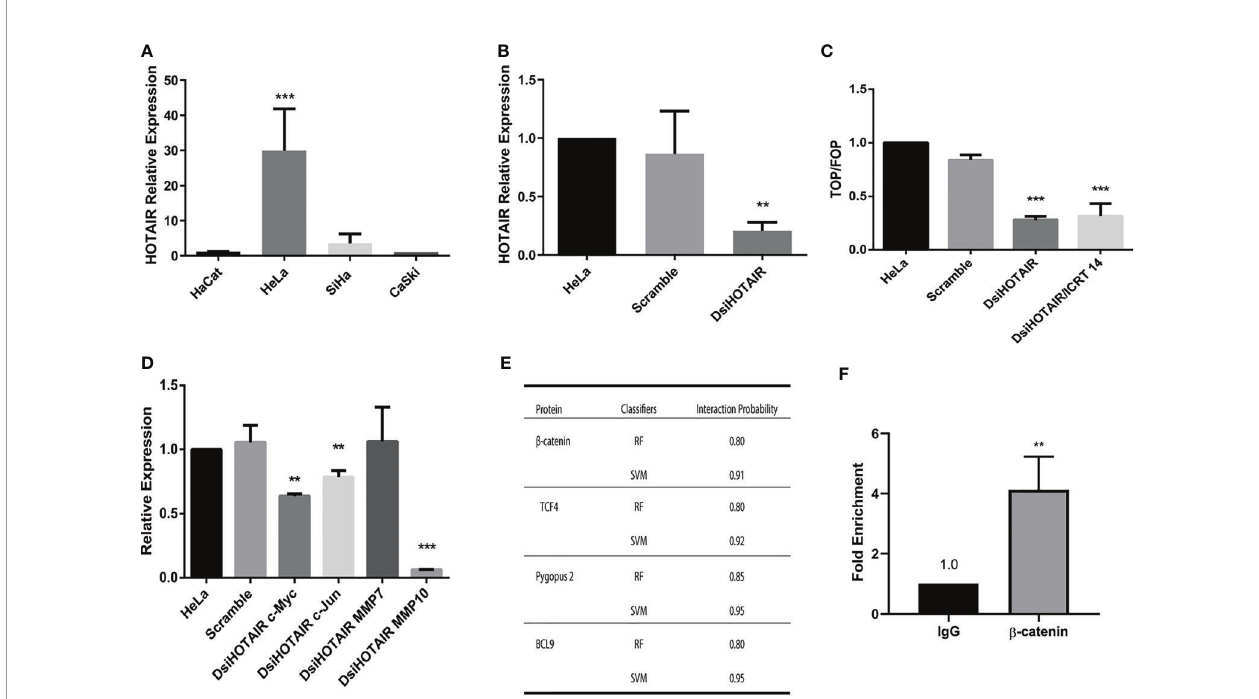
FIGURE 6 | HOTAIR maintains Wnt/ b -catenin pathway active in HeLa cells by avoiding the effect of ICRT14. (A) Relative expression of HOTAIR was determined by RT-qPCR on CC cells. (B) HeLa cells were transiently transfected with 30 µM of DsiHOTAIR. After 48 hrs of post-transfection, the expression of HOTAIR was measured. (C) HeLa cells were transiently transfected with 30 µM of DsiHOTAIR alone or in combination with 12.9 µM of ICTR14 and the activity of Wnt/ b -catenin pathway was detected by TOPFlash assay at 48 hrs. (D) The relative expression of c-Myc, c-Jun, MMP7 and MMP10 was determined by RT-qPCR from HOTAIR knockdown HeLa cells. (E) Interaction probability between HOTAIR and b -catenin detected by RPIseq tool. RIPseq uses the classi fi ers of random forest (RF) and support vector machine (SVM) for calculation. (F) Relative RIP assays using qPCR to detect binding between b -catenin and HOTAIR in HeLa cell line.The bars represent the mean ± standard deviation from at least three independent experiments. *p < 0.05; **p < 0.01 and ***p < 0.001.